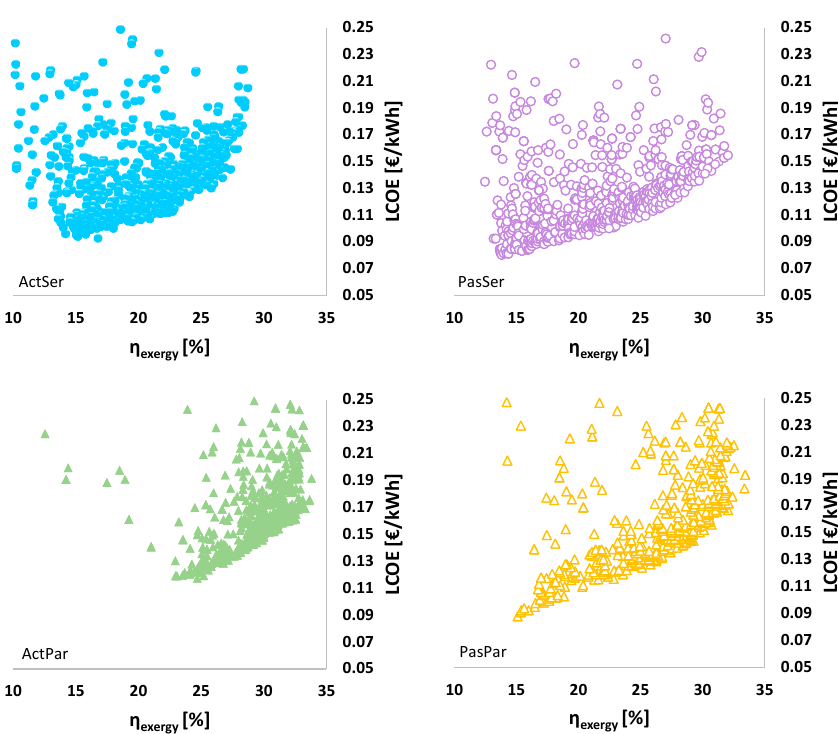
Figure 8. Results of local evaluations by the algorithm.